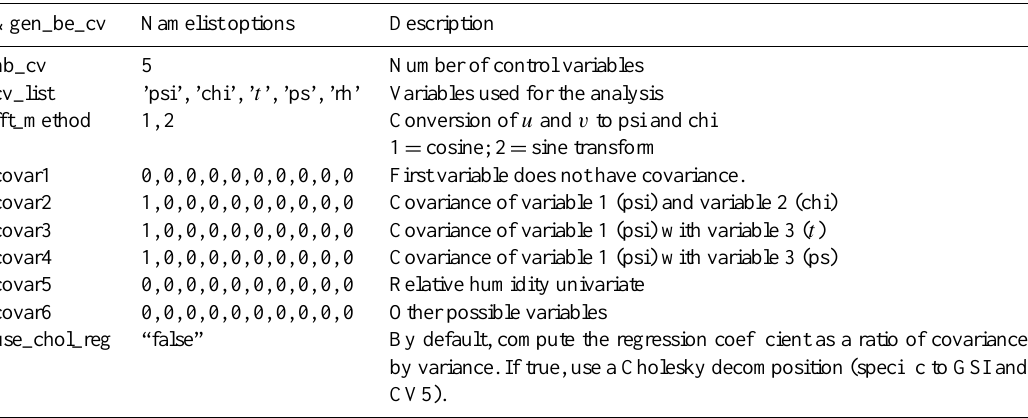
Table B4. Information related to the control variables and their covariance errors in the namelist input file (&gen_be_cv part, example CV5). At present, the parameter covar can take three values, 0, 1, and 2, meaning “no regression”, “full regression” and “diagonal only”.